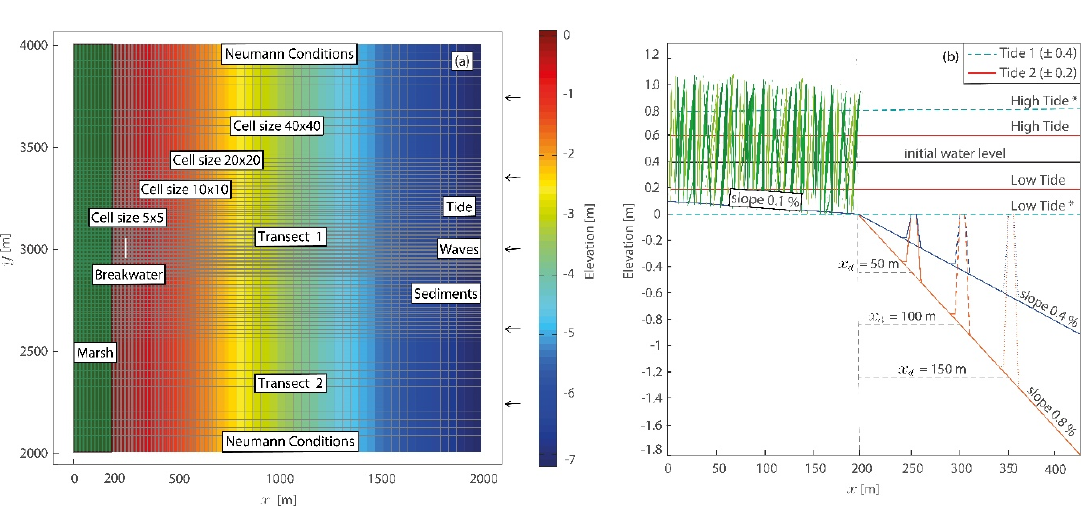
Figure 1. Domain configuration. Plot ( a ) planimetry of the model with cells dimension and boundary conditions on the North / South side (Neumann condition) and East side (waves, tide and sediment concentration). Transect 1 and 2 will be used later in the paper for making a comparison on breakwater e ff ect on sediment transport. Plot ( b ) longitudinal profile of the domain with the two di ff erent slopes used (blue line = 0.4% and orange line = 0.8%), with three di ff erent breakwater positions and two tide conditions (red continuous line = ± 0.2 m and cyan dashed line = ± 0.4 m).